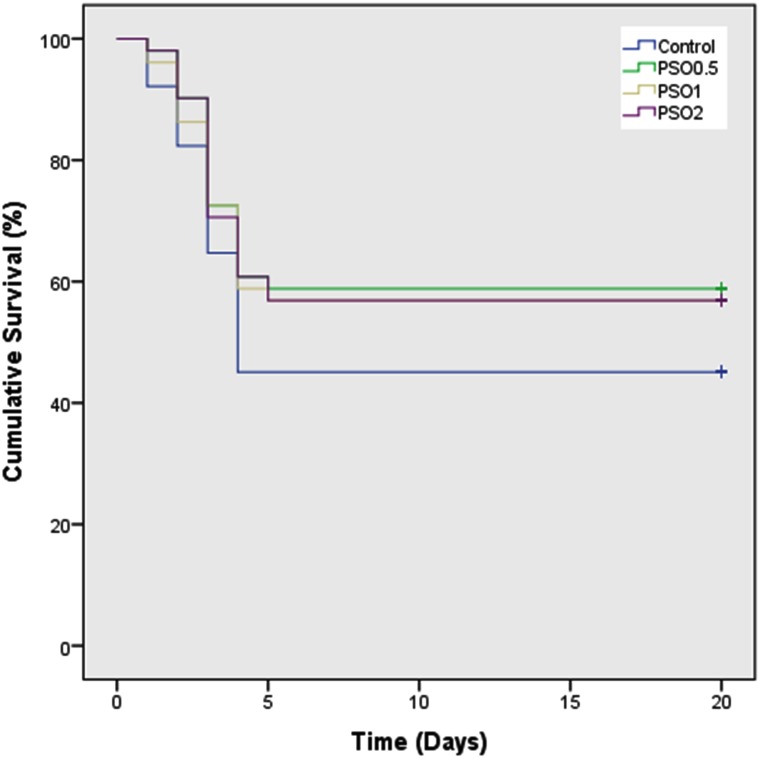
Kaplan–Meier survivorship curves (cumulative survival [%] over time [days]) for rainbow trout after challenge with Yersinia ruckeri; the fish were fed with pomegranate seeds oil supplemented diets (0, 5, 10, or 20 g of PSO/kg of feed; diets PSO0, PSO5, PSO10, and PSO20, respectively) prior to bacterial challenge 209 mm × 232 mm (300 × 300 DPI).